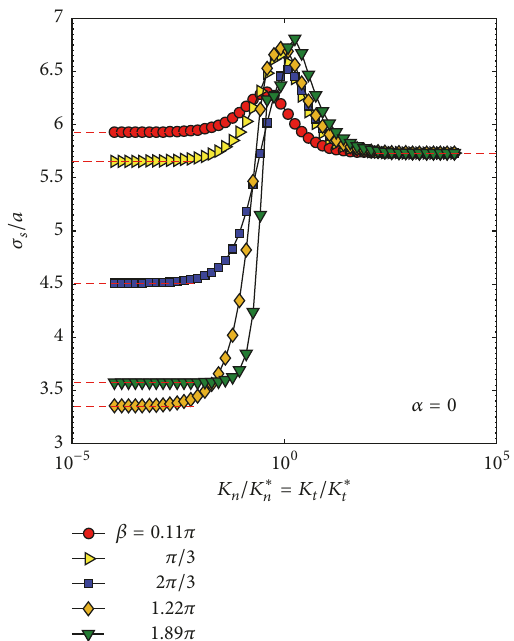
Figure 4: The calculated SCS by a partially imperfectly bonded fiber as a function of the stiffness in the range of 10 −4 to 10 4 .